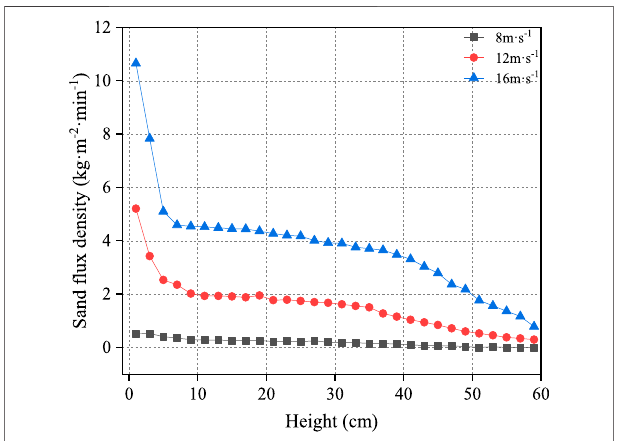
FIGURE 16 | Histogram of sand control ef fi ciency at 10H 2 behind the three rows of windbreak forest belts under different incoming wind velocities.